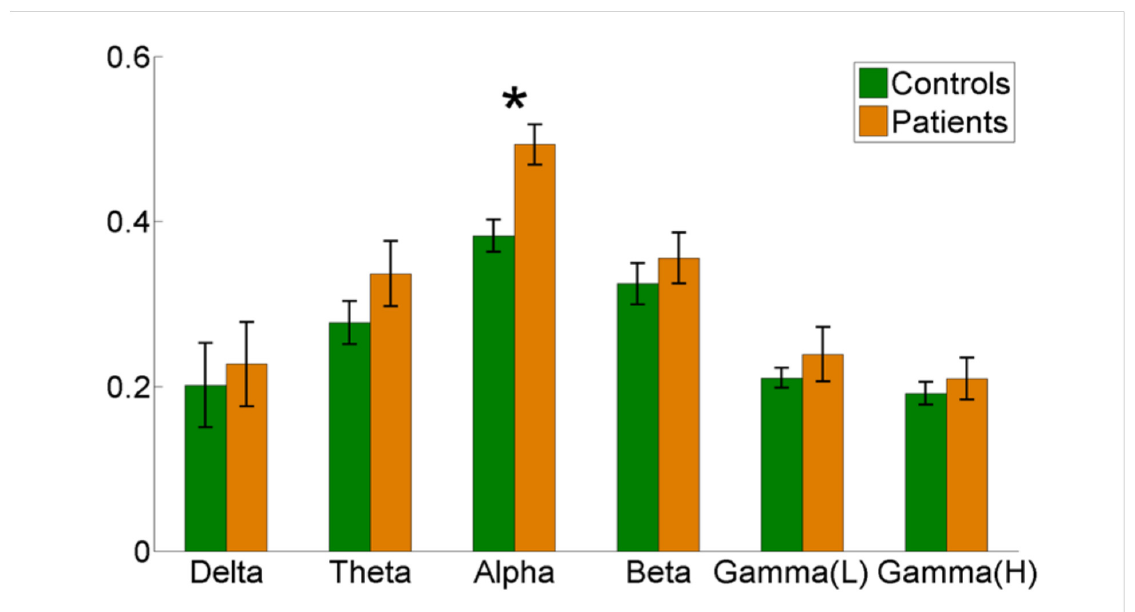
Fig 4. Aggregated nodal network connectivity. Assortativity of Partial Directed Coherence, showing differences between patients (Yellow) and controls (Green) with p = 0.0032 for Alpha range (Delta p = 0.74, theta p = 0.26, beta p = 0.46, gamma p =